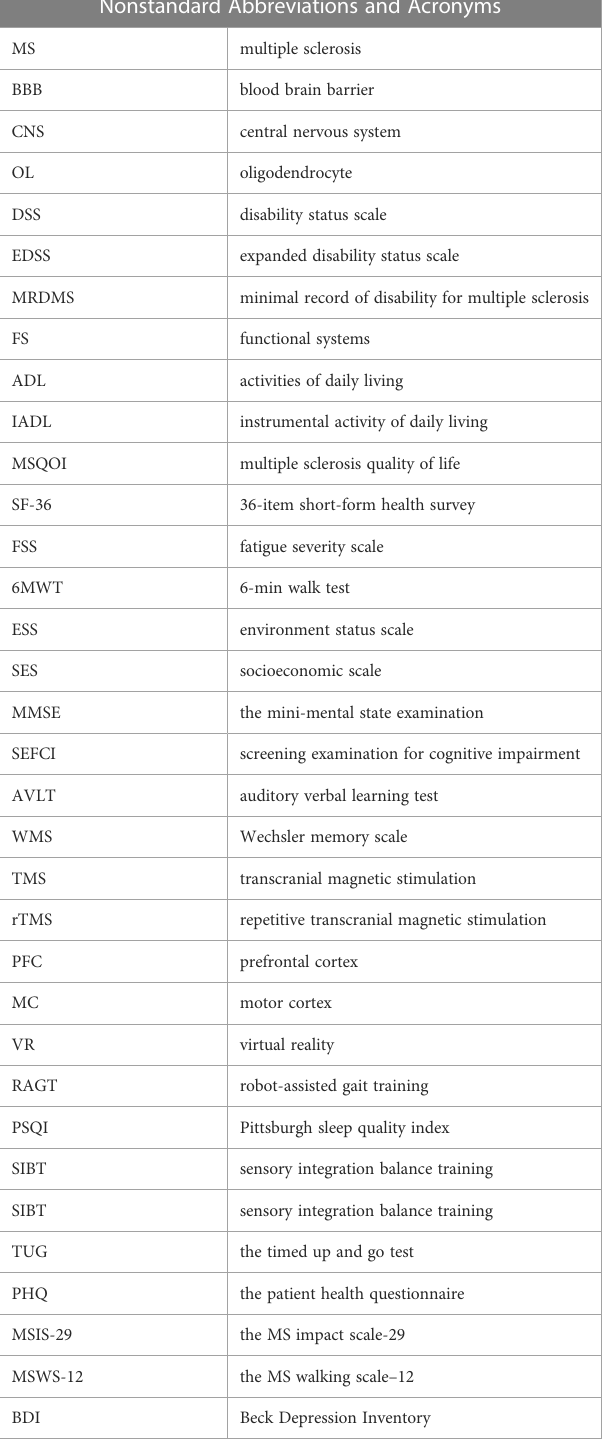
TABLE 1 Nonstandard Abbreviations and Acronyms. Nonstandard Abbreviations and